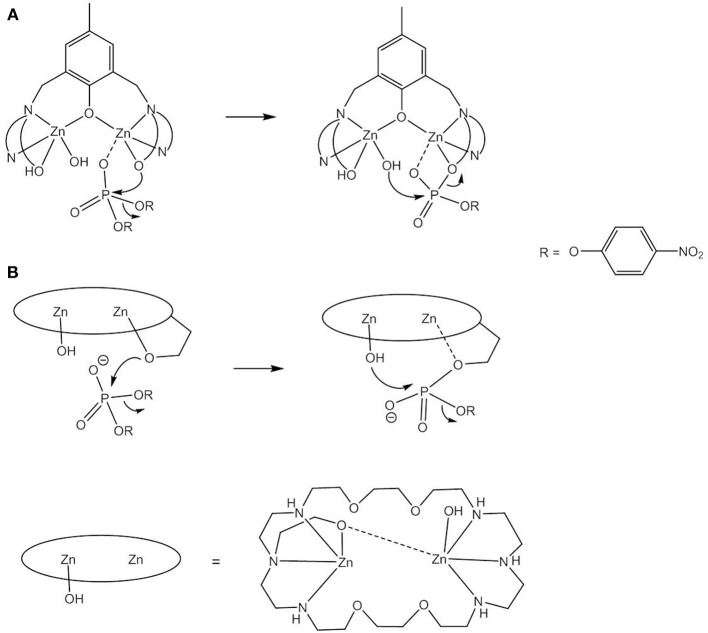
Sequential involvement of a Zn-OR and Zn-OH nucleophile in the cleavage of BNPP by [Zn2HL5]2+(A) and [Zn2L6(OH)]2+
(B).